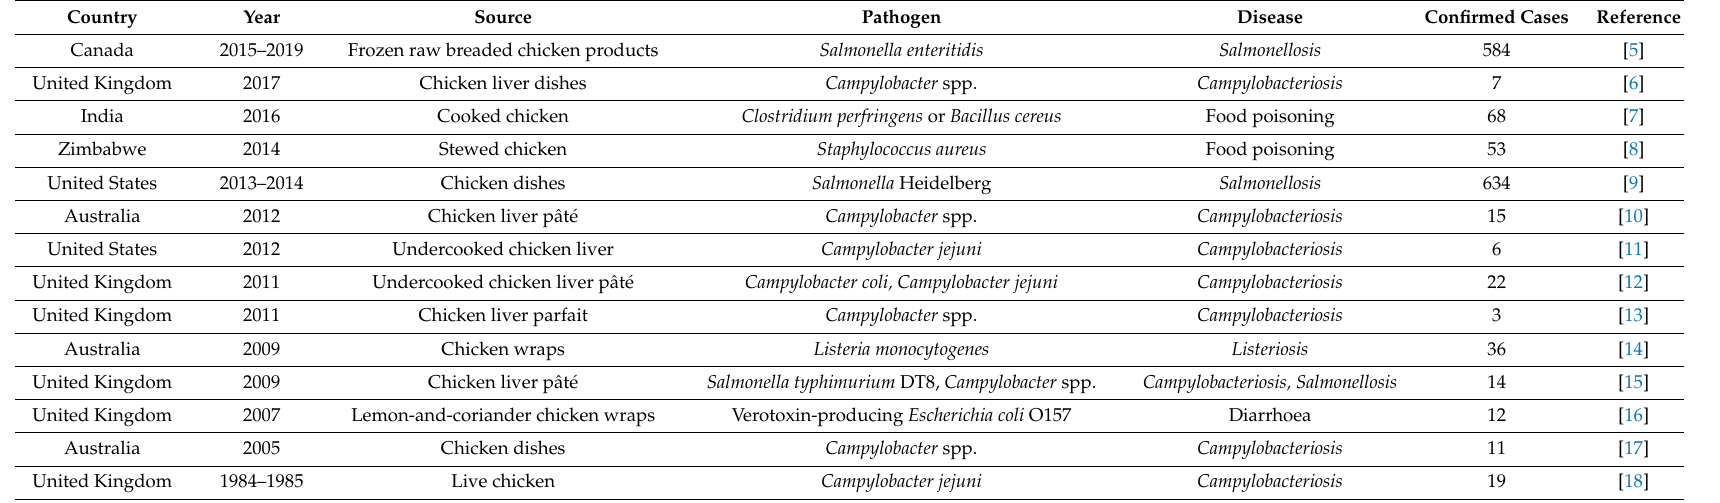
Table 1. Disease outbreaks due to chicken / meat